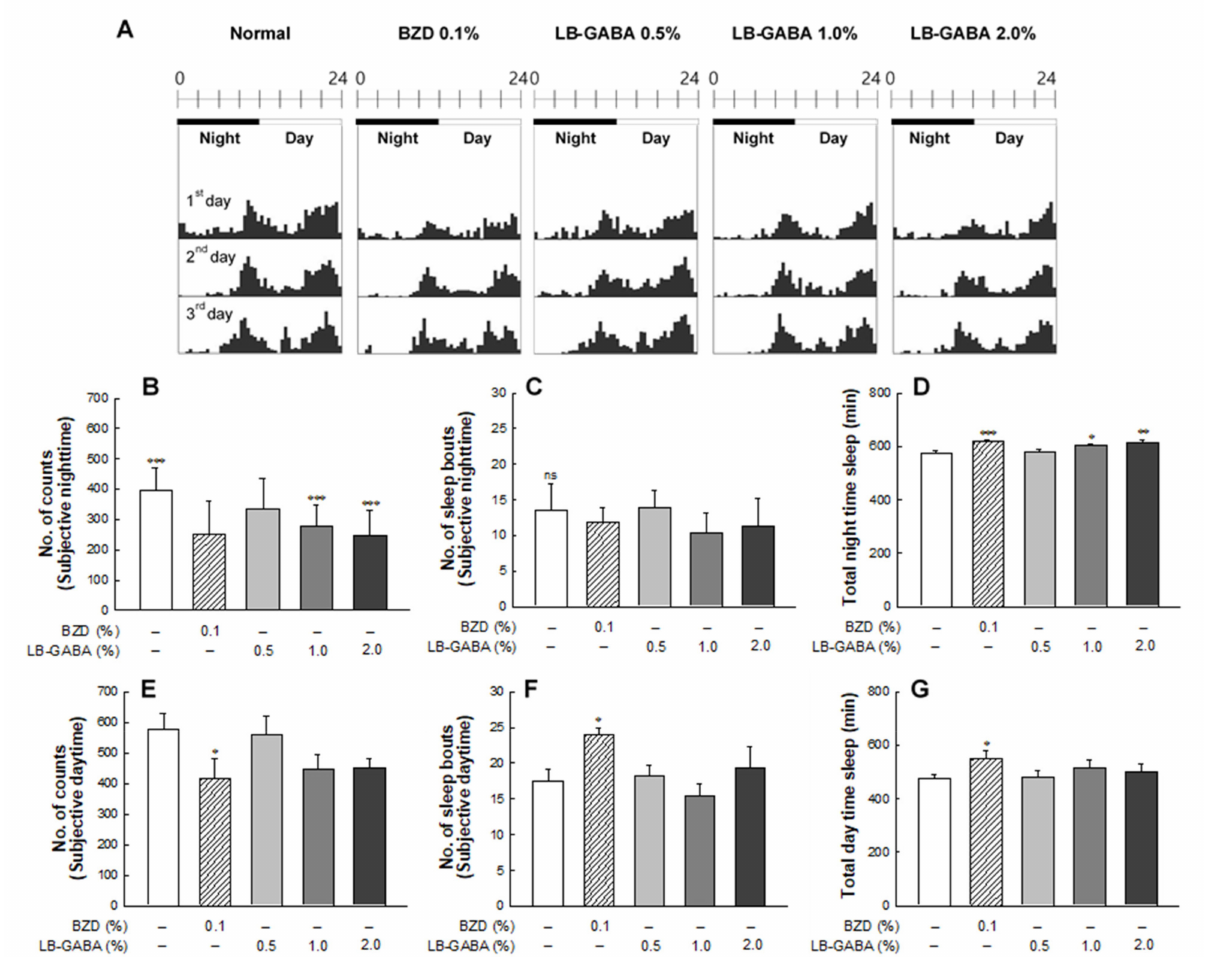
Figure 2. Effects of Lactobacillus -fermented γ -aminobutyric acid (LB-GABA) on Locomotor Activity in Fruit Flies. Constant nighttime and daytime behavioral analysis was conducted for 3 days. ( A ) Locomotor activity of control, alprazolam-treated (benzodiazepine, BZD), and LB-GABA-treated flies ( n = 90/group) displayed in representative actograms. Activity detected per 1 min using a sensor was expressed as numbers, and then activity count for 30 min was combined and over 3 days. Actograms of each groups showed daytime (white) and nighttime (black) readings (h). ( B ) Subjective nighttime activity. ( C ) Nighttime sleep bouts. ( D ) Total nighttime sleep duration. ( E ) Daytime activity. ( F ) Daytime sleep bouts. ( G ) Total daytime sleep duration. Values are means ± standard deviation (SD); * p < 0.05, ** p < 0.01, and *** p < 0.001 versus normal control group (NOR) according to Tukey’s multiple comparison test; ns, not